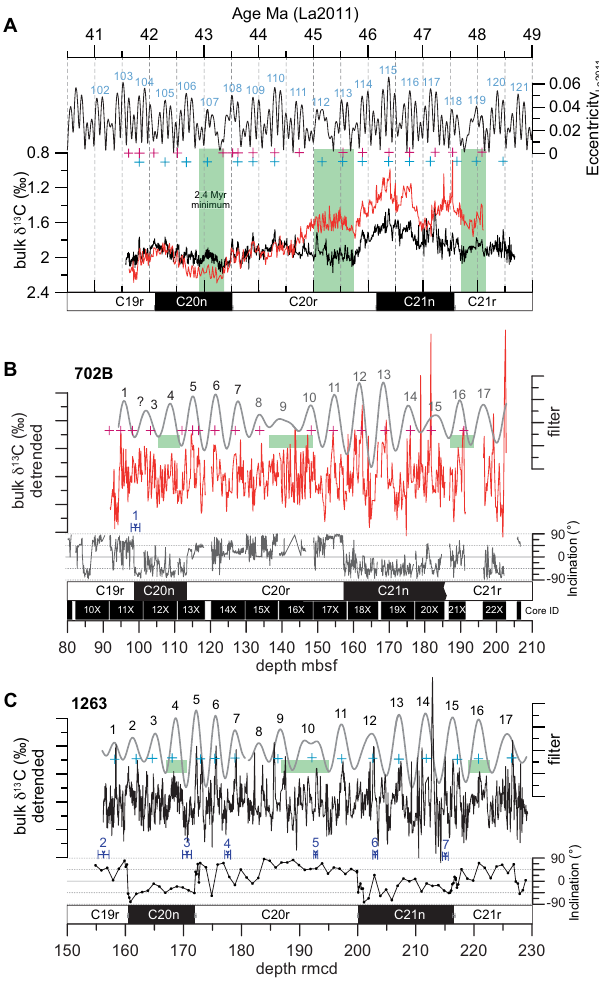
Figure 5. Middle Eocene cyclostratigraphic synthesis for ODP Sites 702 and 1263, 41–48.5Ma. (a) Orbital eccentricity solution La2011 (Laskar et al., 2011b) and respective 405kyr cycle number with new astronomical calibrated ages for magnetic polarity chrons C20n, C20r and C21n. Bulk stable isotope data from Sites 702 (red) and 1263 (black) on the new astronomically tuned age model. Green bars show the minima in the amplitude modulation related to the 2.4Myr cycle in eccentricity. (b, c) ODP Site 702 and 1263 de- trended bulk stable isotope data and band-pass filter of the 405kyr related eccentricity component (Site 702: 0.16 ± 0.048cyc.m − 1 ; Site 1263: 155–180rmcd 0.29 ± 0.087cyc.m − 1 , 180–230rmcd 0.23 ± 0.069cyc.m − 1 ), paleomagnetic inclination (Clement and Hailwood, 1991), calcareous nannofossil events (Pea, 2011; Ship- board Scientific Party, 2004), core recovery for Site 702. Black numbers indicate individual 405kyr cycles determined by combin- ing records from both sites. Red and blue crosses indicate tun- ing tie points. Calcareous nannofossil events: 1, base R. umbilicus